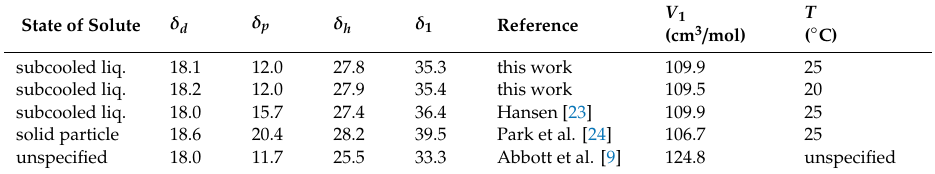
Units for all solubility parameters are in (MPa) 0.5 . Calculations based on ascorbic acid molar volume V 1 ( T ). Presumed uncertainty ∆ δ 1 = ± 1 (MPa) 0.5